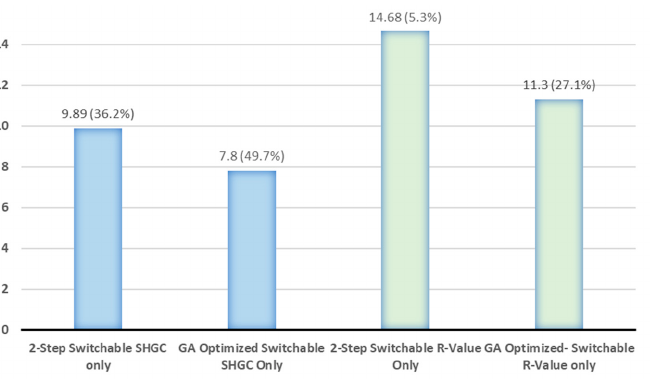
Figure 6. Reducing loads for optimized STIS and/or smart windows applied to a house in Golden, CO, USA—21 May.